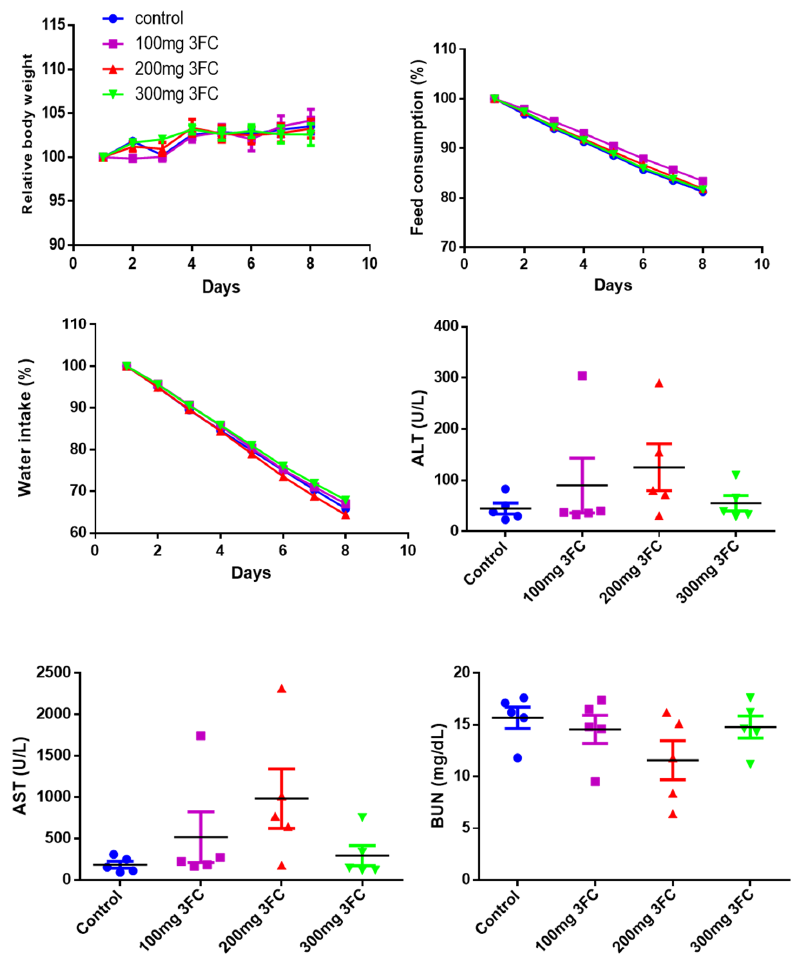
Figure 3. Levels of serum biochemical markers such as alanine aminotransferase (ALT), aspartate aminotransferase (AST), and blood urea nitrogen (BUN) in the control group and the groups treated with 3FC at the intraperitoneal administration of 100, 200, and 300 mg/kg body weight. Eight-week-old male mice ( n = 5) were intraperitoneally administered with indicated doses of 3FC, and the changes in body weight, food consumption, and water intake were analyzed. After 8 days, animals were sacrificed, and blood was collected and analyzed for the activity of ALT, AST, and BUN to study the toxicity profile of 3FC. The p -value was non-significant among all groups.